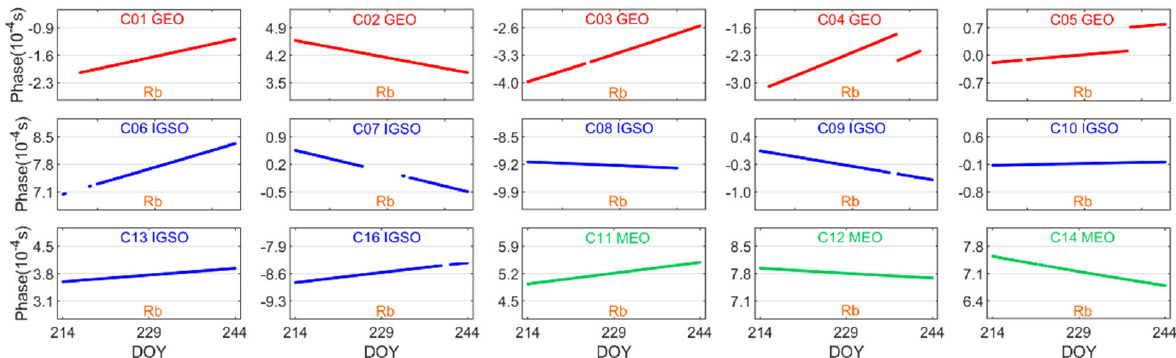
Figure 5. Phase series of BDS-2 satellites.